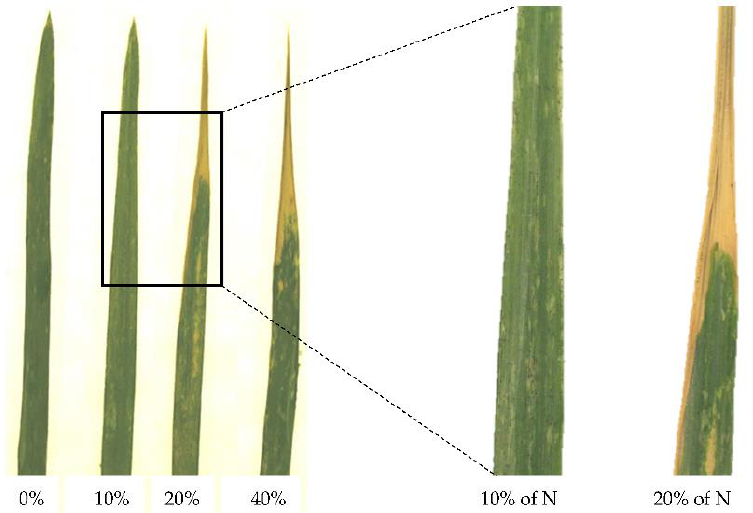
Figure 1. Scorching at the tip of the youngest fully expanded leaf of spring wheat (cv. Amaretto) plants 24 h after spraying UAN solution with different N concentrations (0, 10, 20, and 40% of N) without